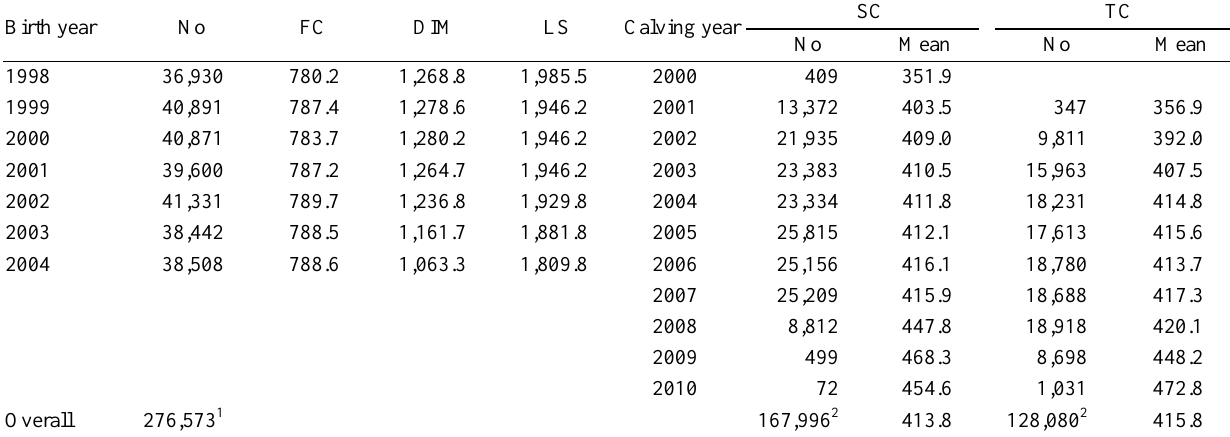
Table 1. Distribution and means of the reproductive and productive life traits Birth year